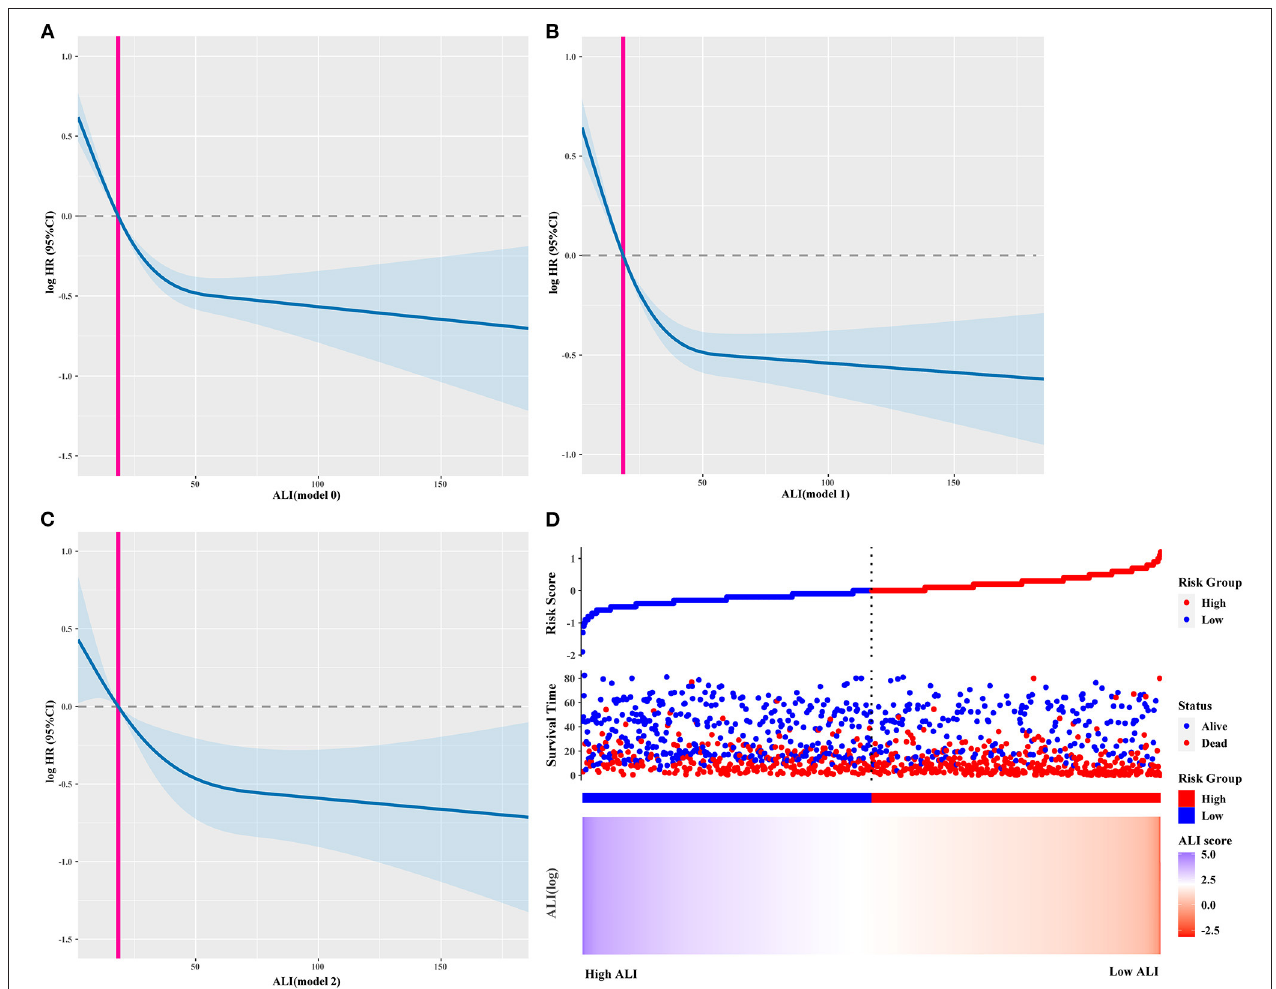
FIGURE 3 | The restricted cubic spline curves and ALI risk model curve. (A–C) The restricted cubic spline curves of different adjusted models, (A) model 0: Unadjusted; Model 1: Adjusted for Age, Sex and TNM stage; Model 2: Adjusted for Age, Sex, Radical resection, TNM stage, EORTC QLQ-C30, KPS, Neoadjuvant chemoradiotherapy, Postoperative chemoradiotherapy, Lymphocytes, Neutrophils, WBC, AST, ALT, Serum albumin, Comorbid disease (s), Family history of cancer, Tea consumption, Alcohol consumption, Smoking, Platelet, Hemoglobin, Serum total protein, PGSGA, Nutritional intervention, 30-day mortality, HGS; (D) ALI risk model curve. ALI, Advanced Lung Cancer Inflammation Index; WBC, White Blood Cells; AST, Aspartate Aminotransferase; ALT, Alanine Transaminase; HGS, Hand grip strength; BMI, Body Mass Index; EORTC QLQ-C30, The European Organization for Research and Treatment of Cancer (EORTC), Quality of Life Questionnaire-Core 30 (QLQ-C30); PGSGA, Patient-Generated Subjective Global Assessment; KPS, Karnofsky Performance